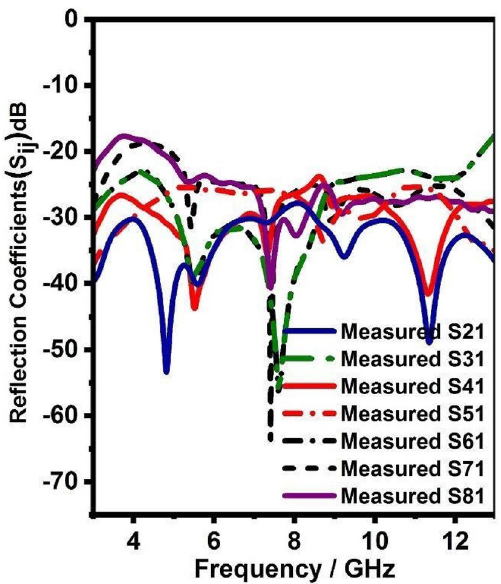
Figure 15. Mutual coupling (Measured) of integrated antenna system.